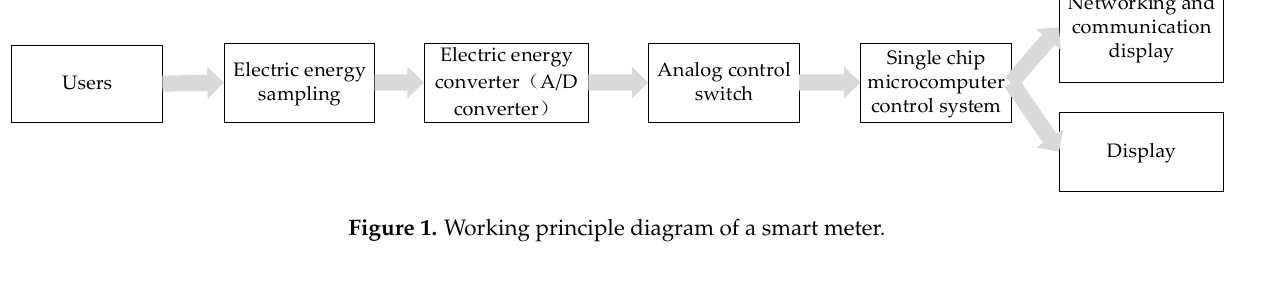
Figure 1. Working principle diagram of a smart meter.